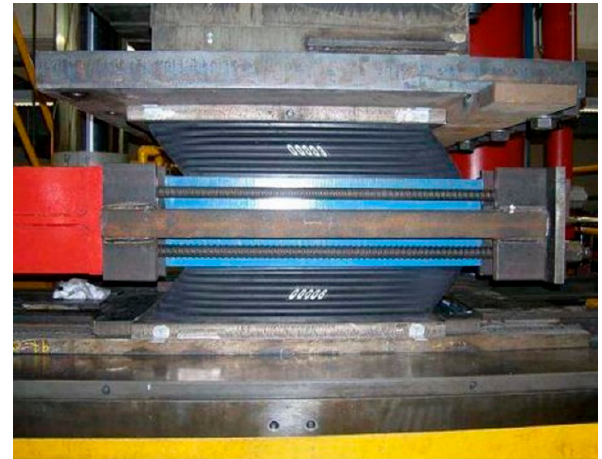
Figure 8. Static compression test assembly [13].